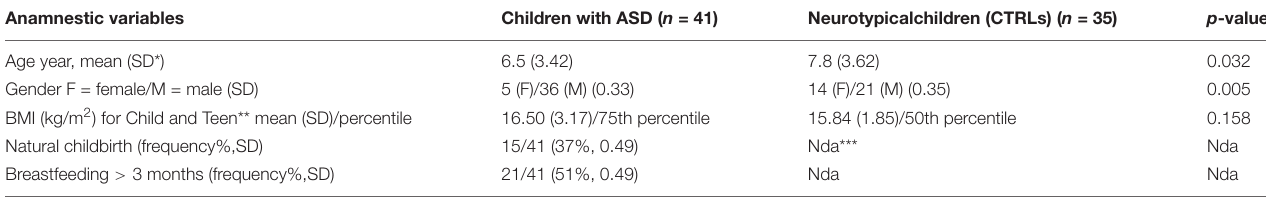
TABLE 1 | Principal anamnestic characteristics of the patients with ASD and CTRLs. Anamnestic variables